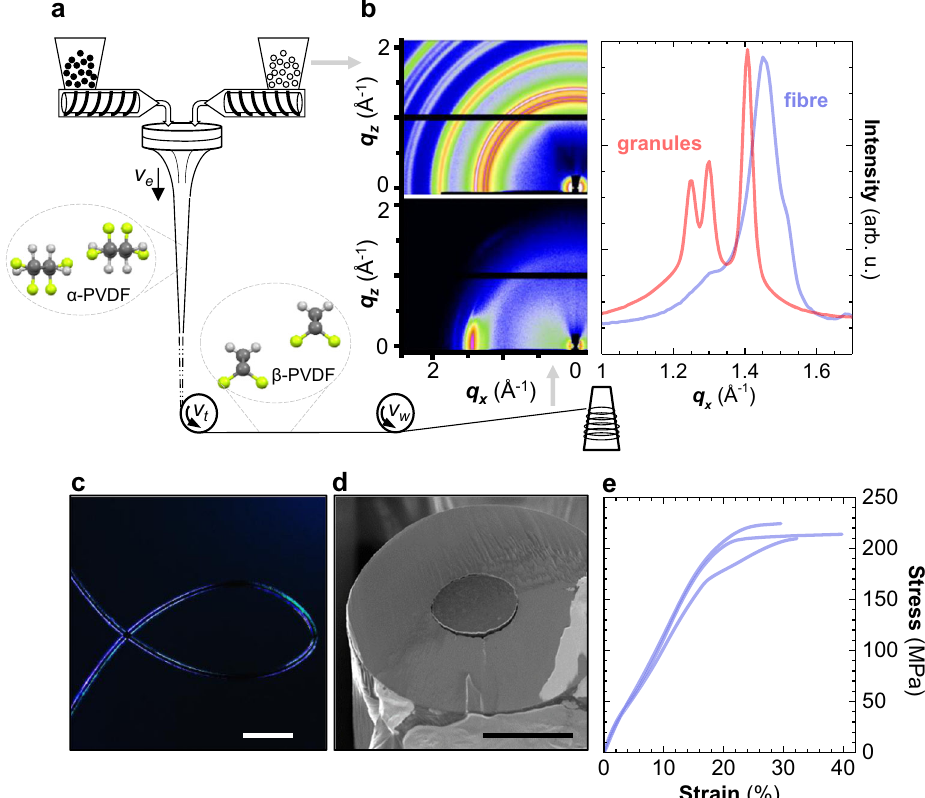
Fig. 1 Melt spinning and structural characterisation of bicomponent fi laments. a Schematic of bicomponent fi bre spinning: the base materials for the core (carbon black/polyethylene) and sheath (PVDF) are fed from two separate extruders through the spinneret, producing a yarn of 24 bicomponent fi laments ( v e = 5.3 m/min; v t = 116 m/min; melt draw ratio v t / v e = 22). The second cold-drawing stage ( v w = 500 m/min; cold draw ratio v w / v t = 4.3) converts the PVDF from α to β phase. b Transmission wide-angle X-ray scattering (WAXS) patterns (left) and diffractograms (right) of PVDF granules (top pattern and red line) and the fi nal bicomponent fi laments (bottom pattern and blue line); c cross- polarised optical micrograph of a single fi lament, scale bar is 200 µm. d Scanning electron microscopy (SEM) image of the cross-section of a single fi lament, scale bar is 20 µm. e Stress-strain behaviour of three samples of bicomponent yarns during tensile